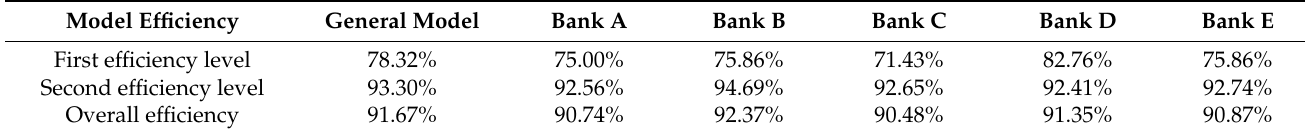
Table 12. Evaluation of the effectiveness of the estimated scoring cards.